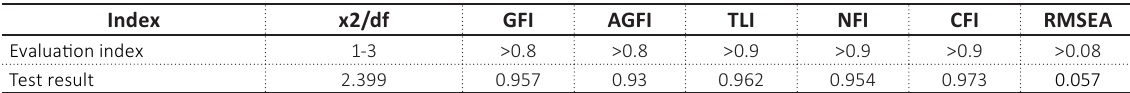
Table 6. Model fitting overall appropriate index